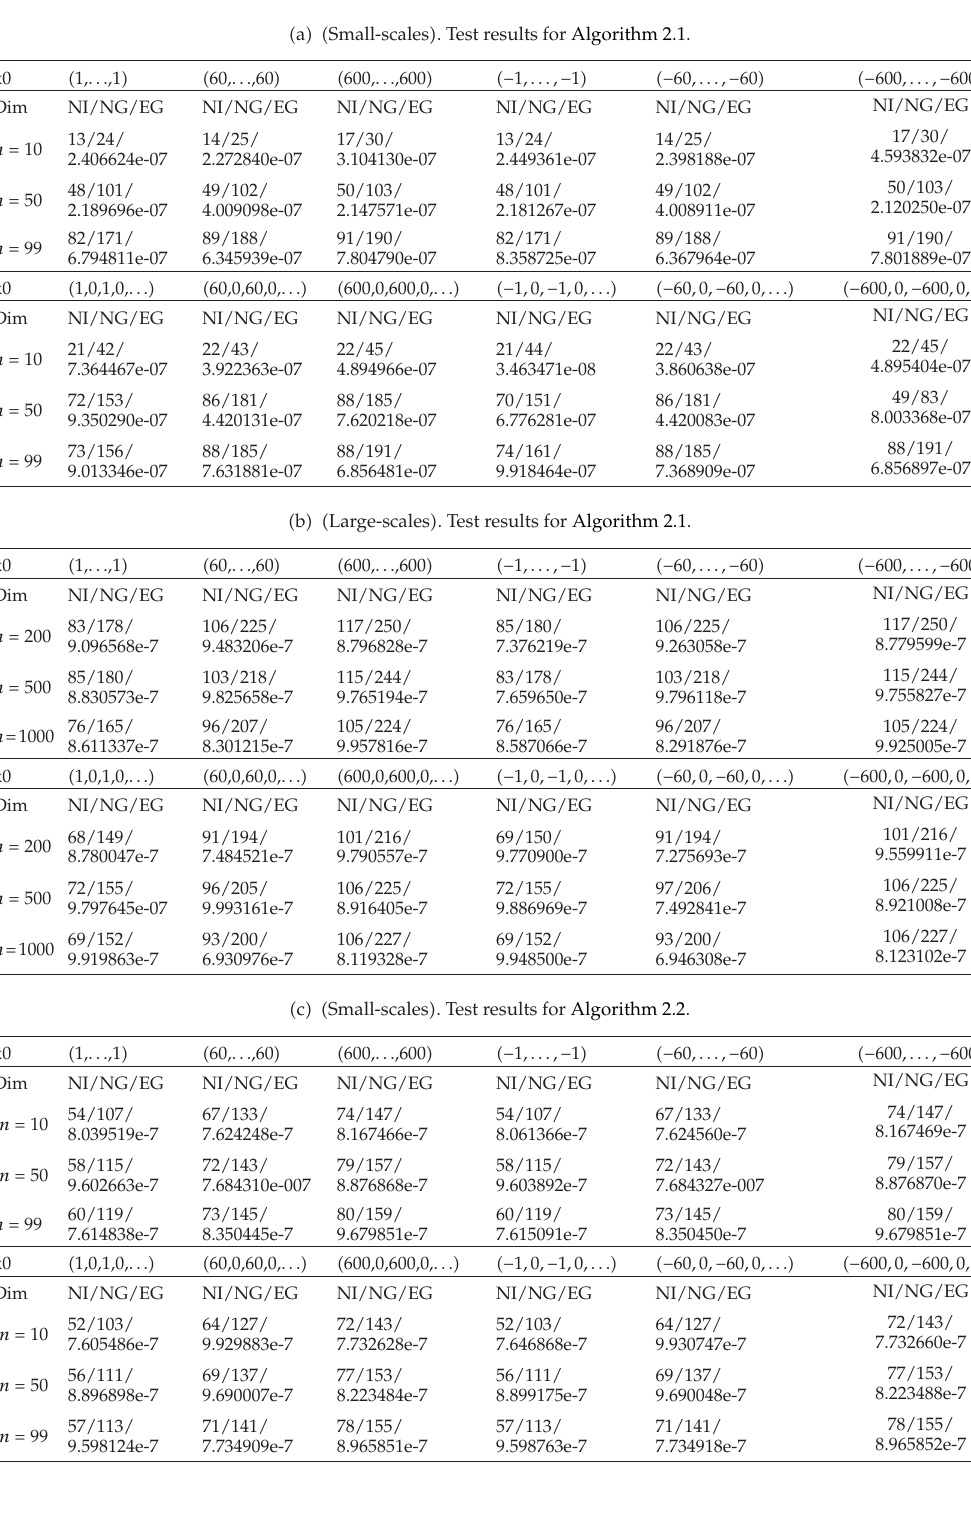
Table 1: Test Results For Problem